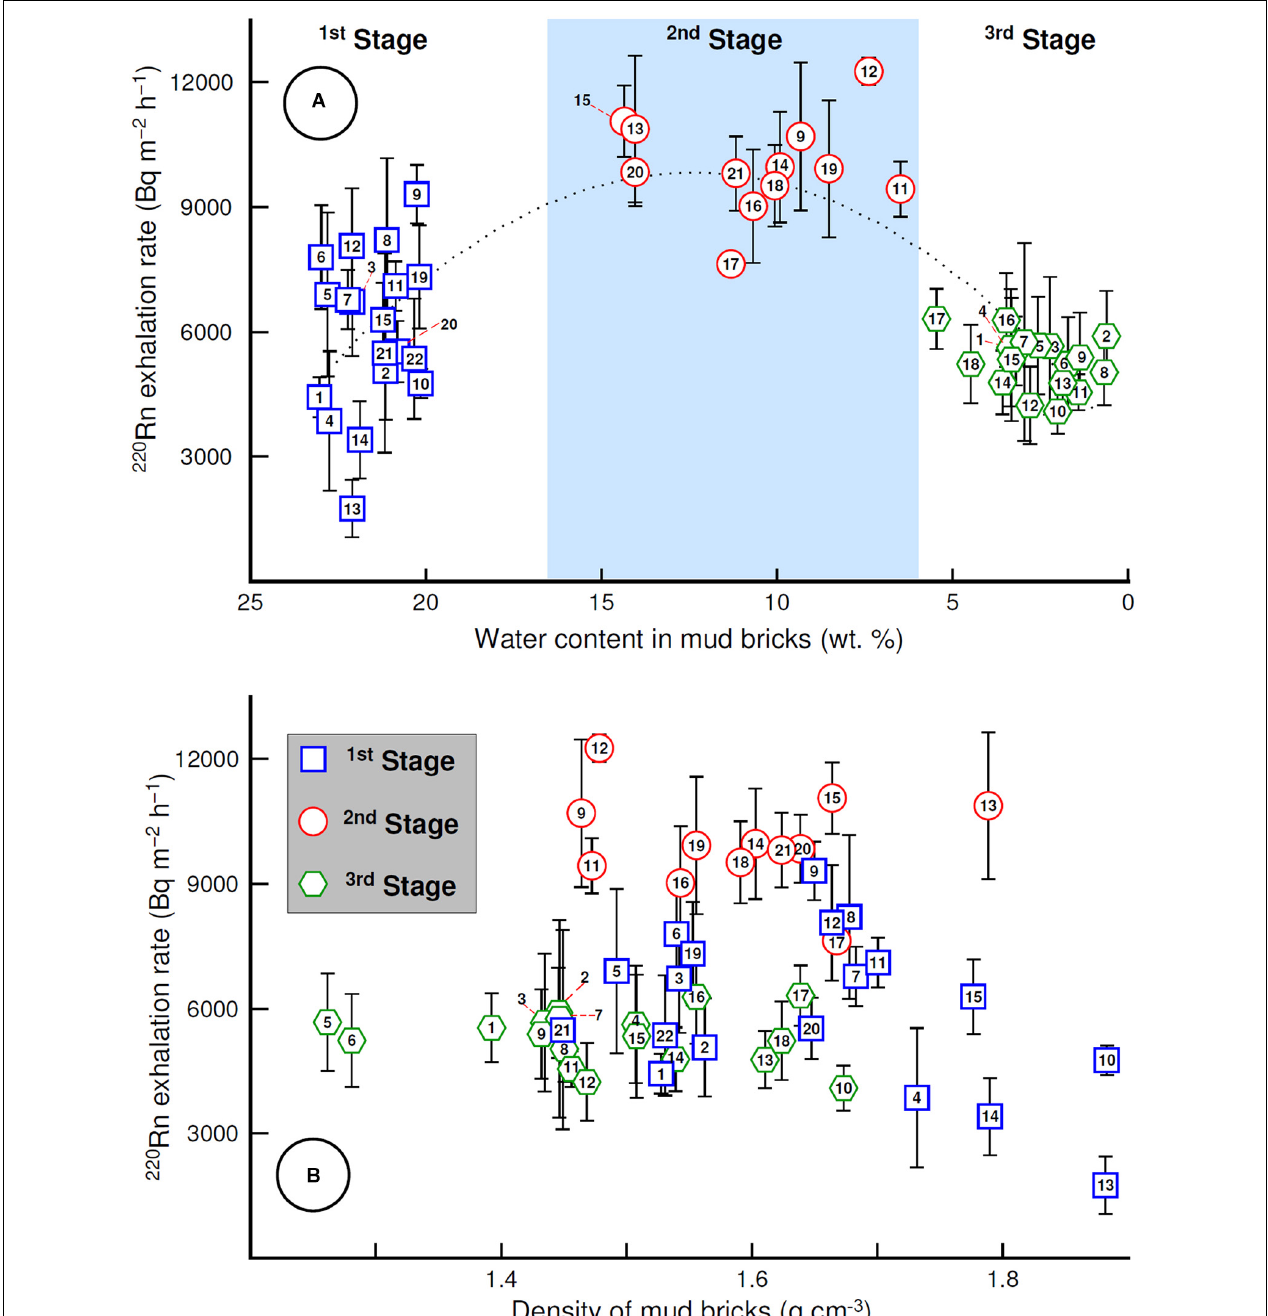
FIGURE 5 | (A) 220 Rn exhalation rates from mud bricks (numbered from 1 to 22) with different moisture contents along three consecutive measurement stages (on January 9, January 18, and December 6, 2017) along slow drying. The dotted line was drawn to guide the eye. (B) 220 Rn exhalation rates from mud bricks versus bulk density. Not all bricks were measured during all stages of